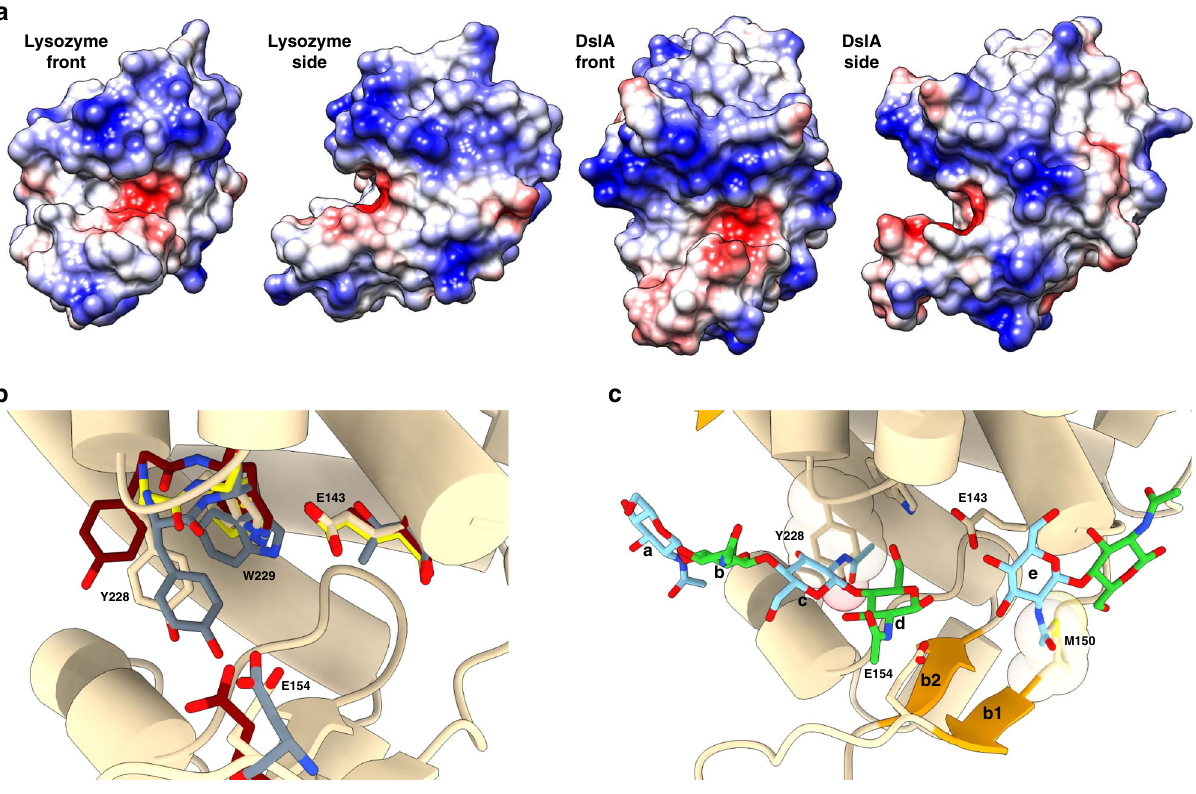
Fig. 6 Active-site cleft and substrate-binding mode. a Surface representation of H. sapiens c-type lysozyme (1LZS) and B. bacteriovorus DslA, with alternating views of active-site cleft. The protein surfaces (1LZS calculated without ligand) have been colored to demonstrate charge using coulombic methods, − 10 to + 10kcal/(mol · e), red to blue. The two enzymes demonstrate a similar patterning at the active-site cleft, despite DslA binding deacetylated peptidoglycan. b Comparison of DslA to non-catalytic members of the lysozyme superfamily. The fold of DslA and residues E143, E154, and Y228-W229 are shown overlaid with equivalent residues from mouse α -lactalbumin (1NF5, gray) 24 , mouse sperm lysozyme-like protein (4YF2, maroon) 25 , and the active enzyme H. sapiens lysozyme (1LZS, yellow) 18 . The YW motif on an active-site loop of DslA is shared with α -lactalbumin and sperm lysozyme-like protein and is equivalent to an AW motif in H. sapiens lysozyme. The D helix catalytic residue of DslA, E143, is replaced by Thr in the two inactive enzymes, but the β -sheet catalytic residue, E154, is retained as either a Glu or an Asp. c DslA superimposed with substrate from a liganded form of lysozyme (1LZS). The classic “ 4 + 2 ” lysozyme saccharide binding pose is shown, with the ligand coordinates from 1LZS superimposed into DslA using the ES motif of both enzymes as a guide. The cell-wall sugar rings are labeled a – f , with GlcNAc and MurNAc residues colored blue and green, respectively. The 2 ′ N-acetyl group of rings c and e face inwardly into the rear face of the active-site cleft and provide a model for deacetylation speci fi city: the sidechains of residues Y228 and M150 (vdw surface shown in transparent) sterically occupy the same space as the acetyl group